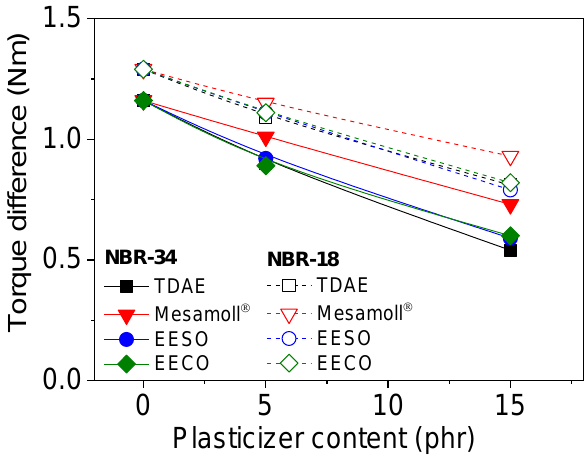
Figure 2. Torque differences during curing of plasticized NBR compounds based on NBR-34 and NBR-18 as a function of plasticizer content.